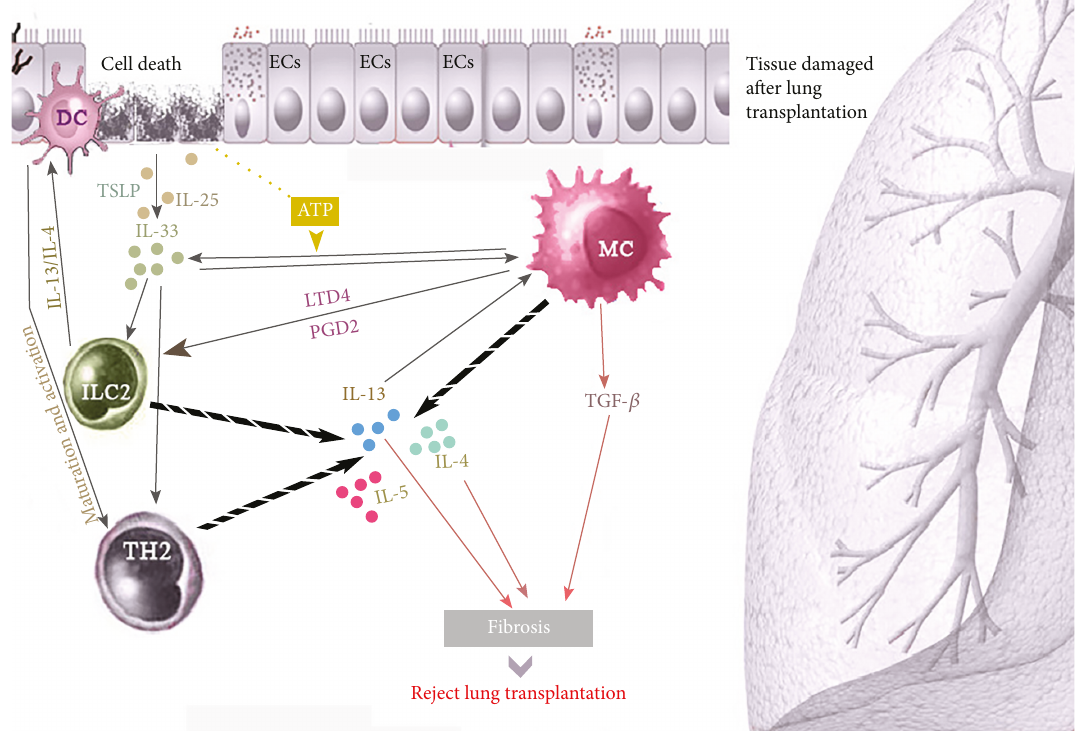
Figure 2: Interactions of mast cells (MC) and type 2 innate lymphoid cells (ILC2) in lung rejection after transplantation. After lung transplantation, damaged airway ECs release mediators such as IL-25, IL-33, and TSLP which caused activation of MCs and ILC2s and the subsequent release of IL-4, IL-5, and IL-13. IL-4 and IL-13 also enhance Th2 cell maturation and activation and stimulate DCs which interact with ECs to enhance the release of IL-33. MCs also produce IL-33 upon activation. The e ff ect of IL-33 on ILC2-mediated release of IL-13 is enhanced by ATP produced by damaged ECs. LTD4 and PGD2 released by activated MCs further recruits and activates ILC2s to produce IL-2, − 4, − 5, − 9, and − 13. IL-13 released by Th2 cells plays a dual role in the induction of organ rejection and in promoting tolerance. Moreover, IL-13 can induce epithelial cell hyperproliferation and collagen deposition leading to pulmonary fi brosis. IL-4 released by MC also triggers fi broblast activation leading to lung fi brosis. MC-derived TGF- β 1 further enhances fi brotic activity. Abbreviations: Areg: amphiregulin; DCs: dendritic cells; ECs: epithelial cell; IL: interleukin; LTD4: leukotriene D4; PGD2: